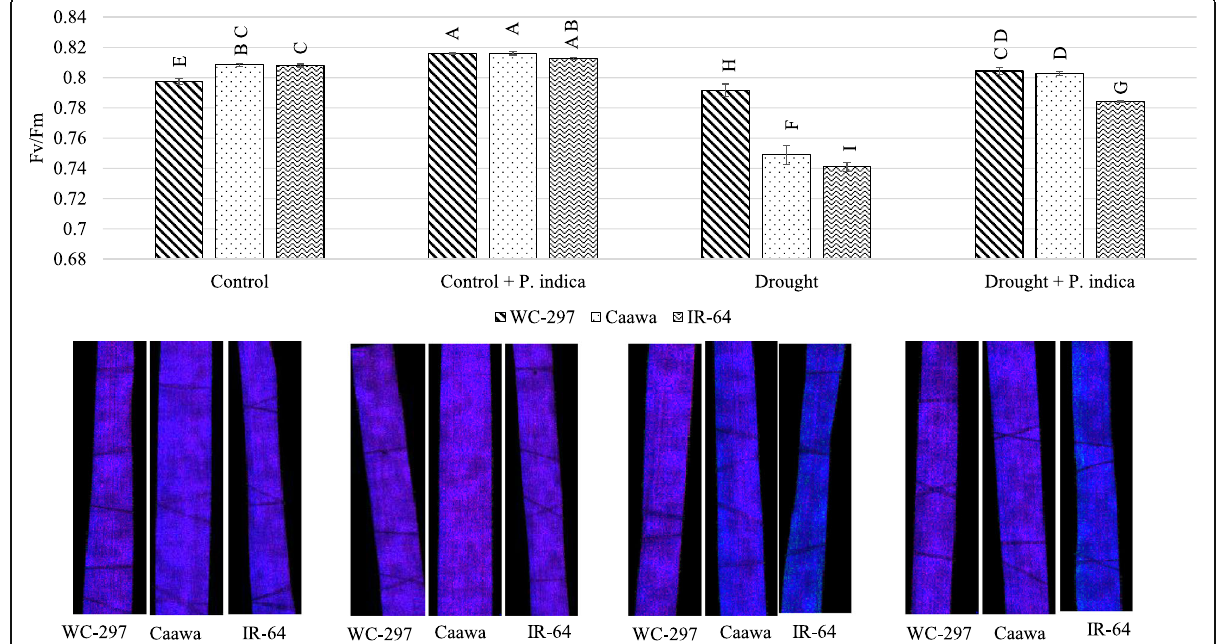
Fig. 6 Change in Fv/Fm. The inoculation with P. indica increased Fv/Fm in both the absence and presence of osmotic stress. Under each bar of the graph there is a picture of the leaf section showing Fv/Fm activity. Alphabetic on the top of each bar are showing the LSD 0.05